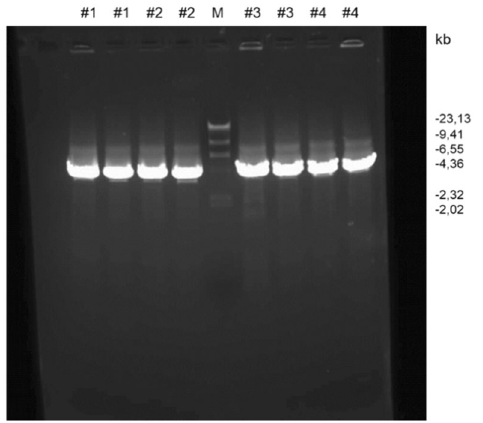
Figure 6. Control of the obtained adenoviral constructs by PCR. 4 selected colonies of bacteria transformed with the vector were subjected to PCR (# 1, # 2, # 3, # 4). Results (in duplicate for each clone) were analysed on an agarose gel. The expected size of positive clones is 4.15 kb. M—DNA size marker Phi X174 HaeIII/Lambda HindIII. All of the clones subjected to the reaction were positive for recombinant DNA